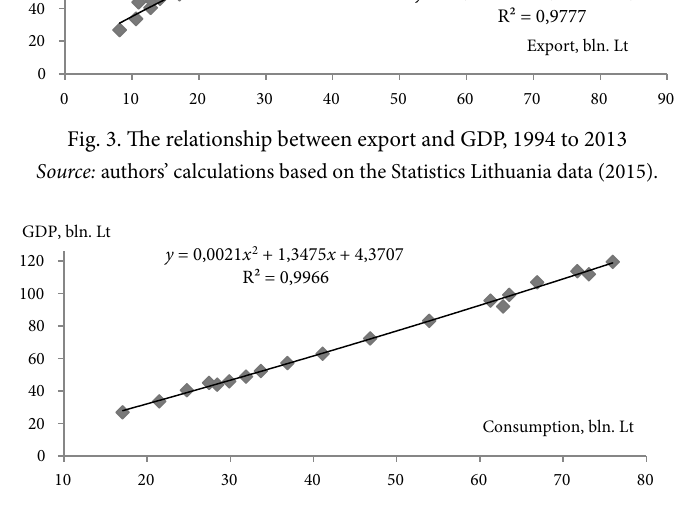
Fig. 4. The relationship between household consumption expenditure and GDP, 1994 to 2013 Source: authors’ calculations based on the Statistics Lithuania data